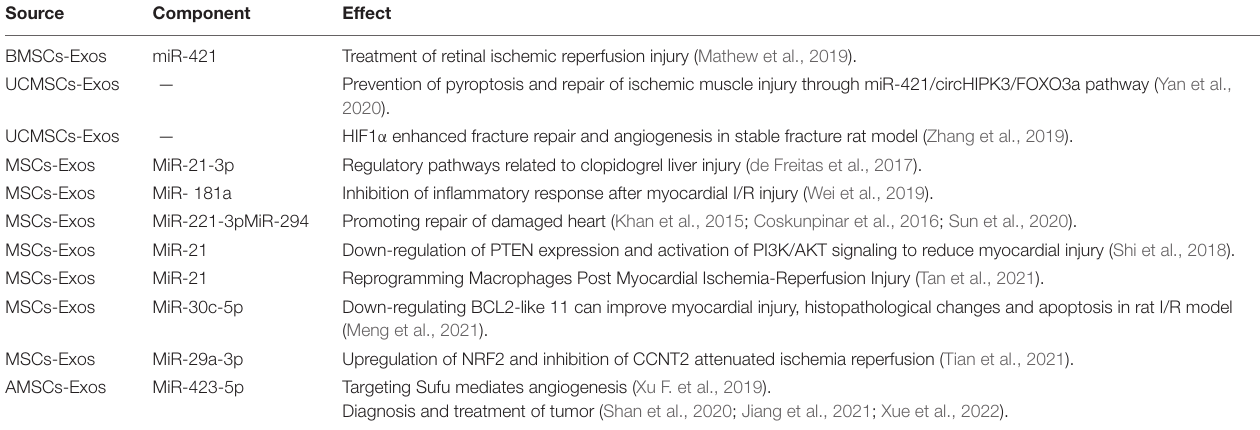
TABLE 1 | Exosomes for the treatment of other diseases. Source Component